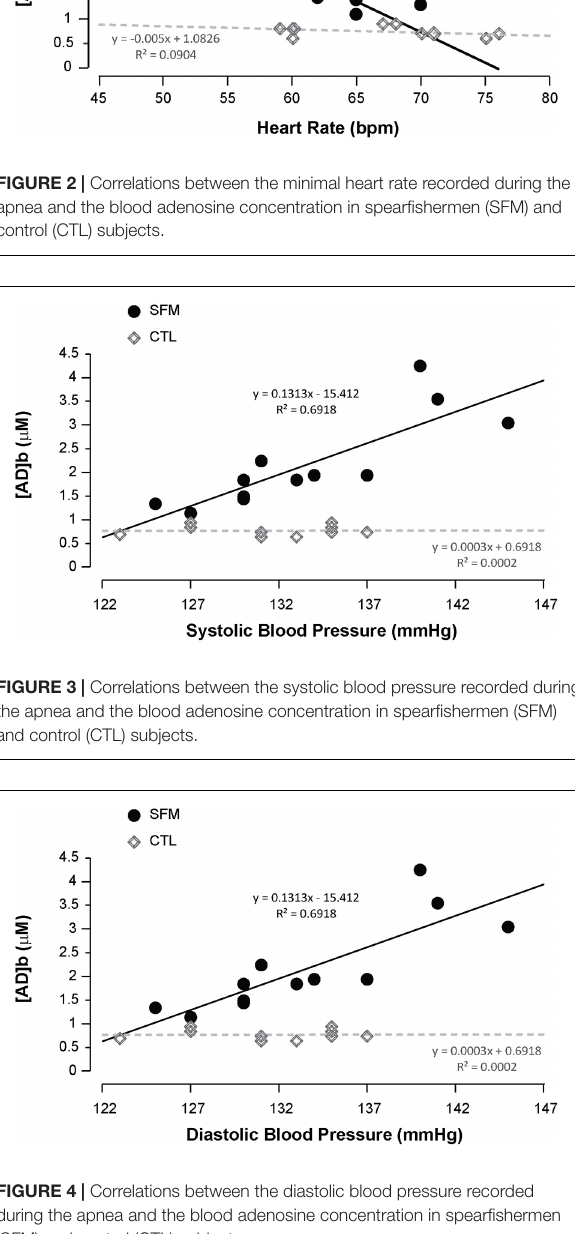
FIGURE 4 | Correlations between the diastolic blood pressure recorded during the apnea and the blood adenosine concentration in spearfishermen (SFM) and control (CTL) subjects.